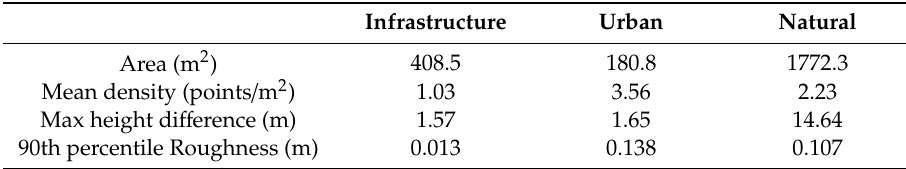
Table 1. Main characteristics of the three test bed